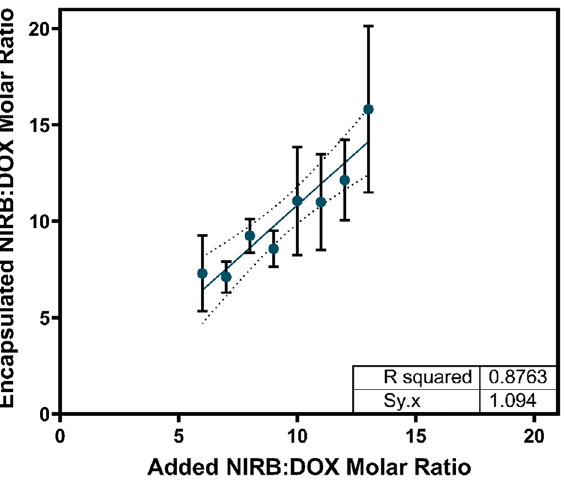
Figure 4. Relationship between the added molar ratio of NIRB:DOX and the corresponding resulting “encapsulated molar ratio” following active loading with TEA 8 SOS as a trapping agent. DOX and NIRB concentrations in the resultant liposomes were quantified by mass spectrometry. Increases in relative molar ratios of encapsulated NIRB:DOX can be linearly related to increases in relative molar ratios of added NIRB:DOX. The determination of this relationship allowed for the formulation of a synergistic NIRB:DOX liposome in a predictable and reproducible fashion. Data is presented as mean ± SD with the dotted lines denoting the 95% confidence interval (n = 3).